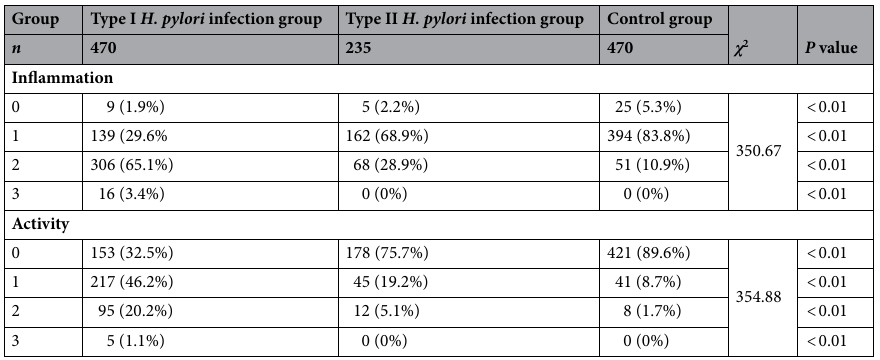
Table 1. The proportion of different types of H. pylori infection in inflammation and activity.